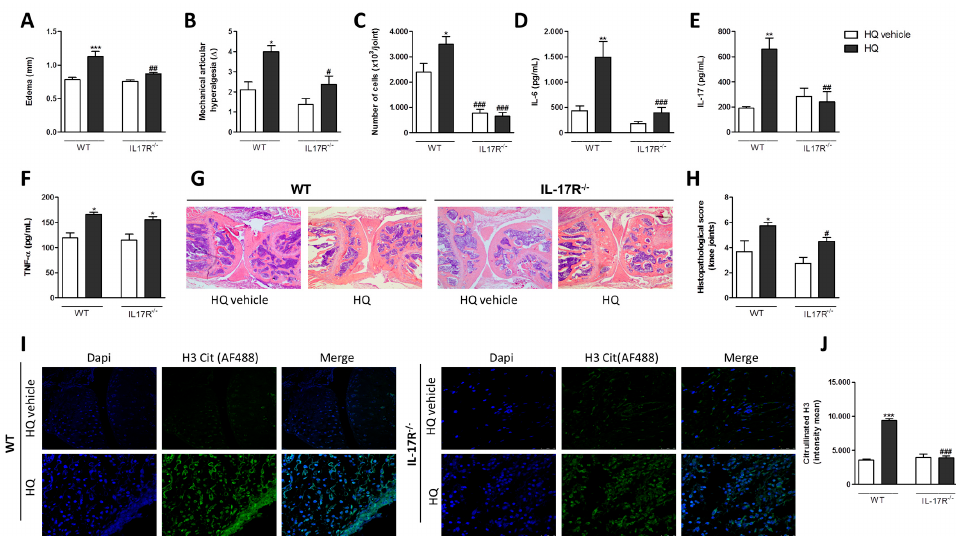
mice were exposed to HQ or vehicle, 1 h/day between days 15–21 after the first immunization. On the 21th day after the first immunization, animals were challenged with mBSA. Six hours later, mice were euthanized and edema ( A ), mechanical articular hyperalgesia ( B ), influx of cells into the joints ( C ), quantification of cytokines IL-6 ( D ) and IL-17 ( E ) and TNF- α ( F ), histopathological analyses ( G , H ) and indirect immunofluorescence analyses of NET formation by assessing the quantification of H3 citrullination ( I , J ) were assessed. ( G ): original magnification—4 × . ( I ): original magnification—40 × . Data represent mean ± SEM of four animals in each group and were analyzed by one-way ANOVA. * p < 0.05, ** p < 0.01 and *** p < 0.001 vs. HQ vehicle; # p < 0.05, ## p < 0.01 and ### p < 0.001 vs. respective group in WT